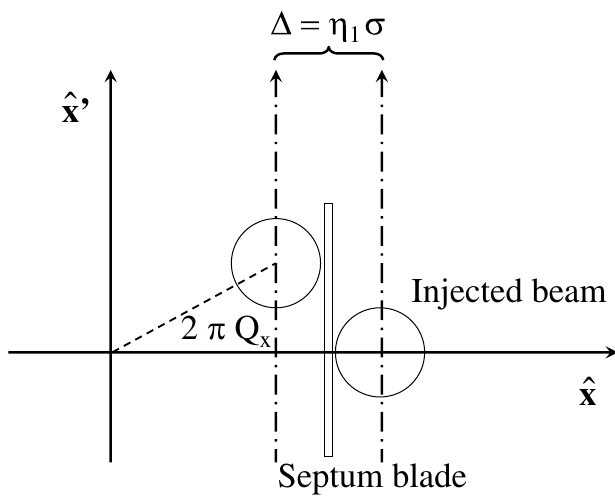
FIG. 10. Sketch of the injection model used to simulate the classical multiturn injection. Two types of reference systems are shown: the one represented by solid lines refers to the center of the vacuum chamber, i.e., the position of the nominal closed orbit once the injection bump is collapsed. The ones represented by dashed lines refer to the instantaneous closed orbit which moves together with the amplitude of the injection bump.